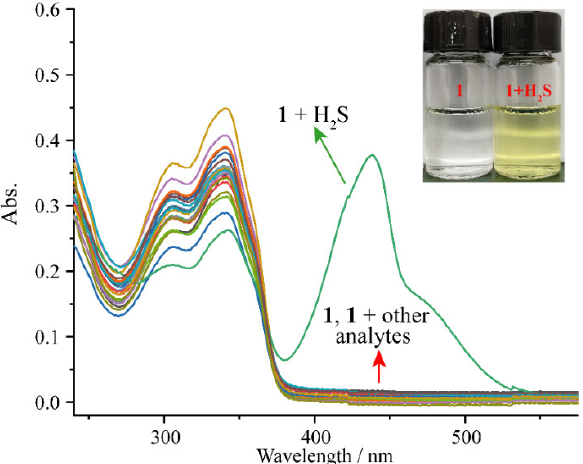
Figure 1. Absorption spectra of 1 (10 μM) treated with various analytes (10 equiv.) in CH 3 CN. The inset was the corresponding color change of 1 following the addition of H 2 S under visible light.